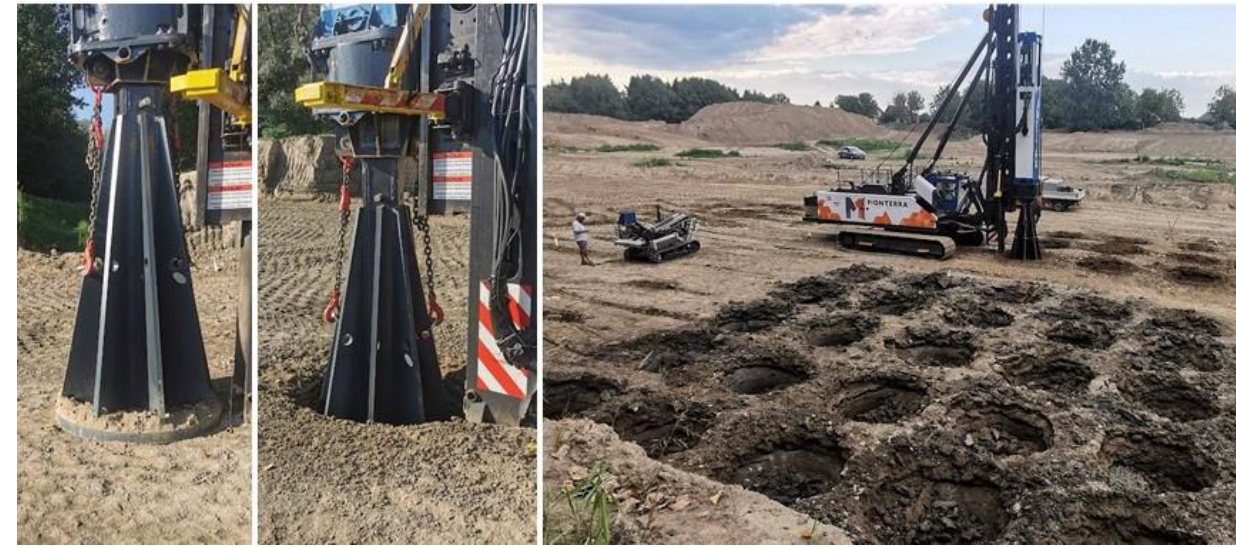
Figure 15. Rapid impulse compaction (RIC) at the Sava river embankment at Galdovo.